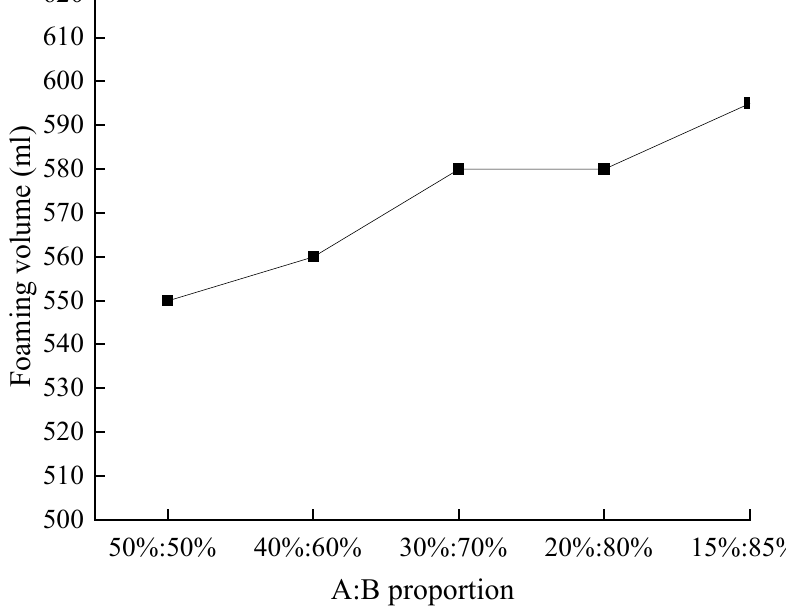
Figure 7. A/E Complex System Bubble Volume Diagram.